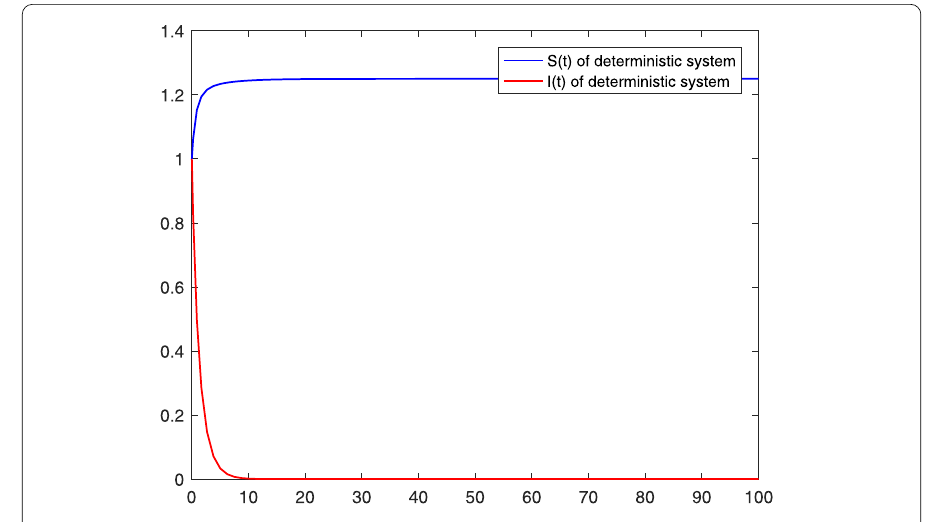
Figure 1 Time series for S ( t ), I ( t ) of deterministic system, with Λ = 0.25, μ = 0.2, β = 0.5, γ = 0.79, α = 0.4, p = 2, where R = 0.5621 < 1